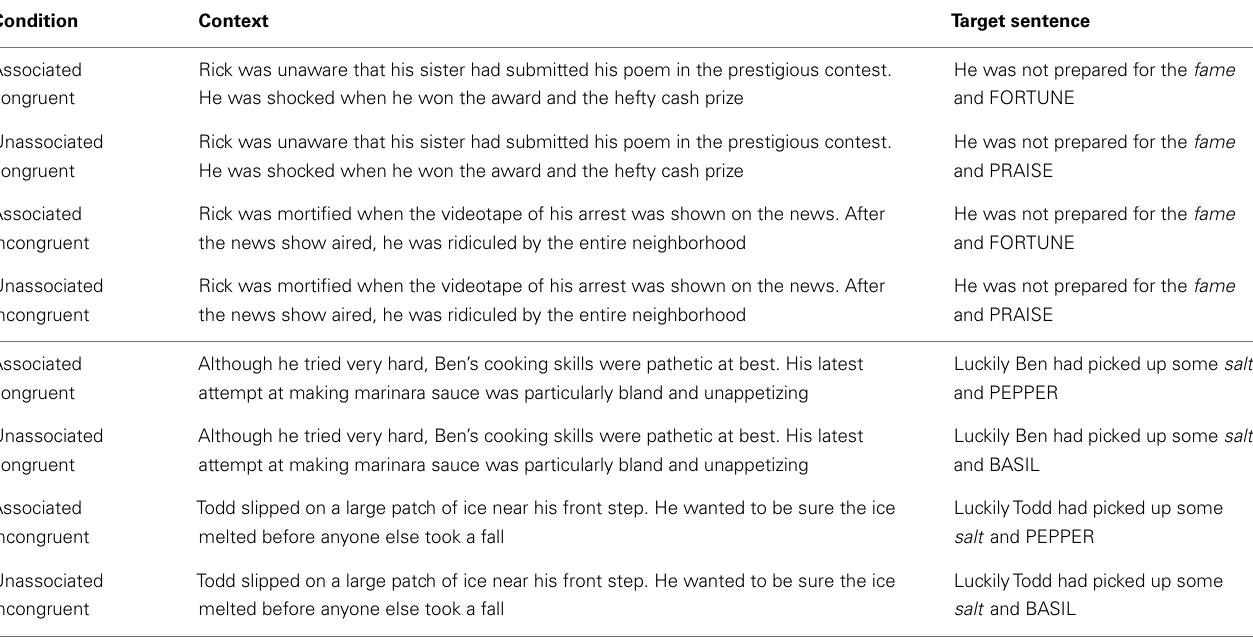
Table 1 | Example stimulus sets showing each of the four conditions described in the text.